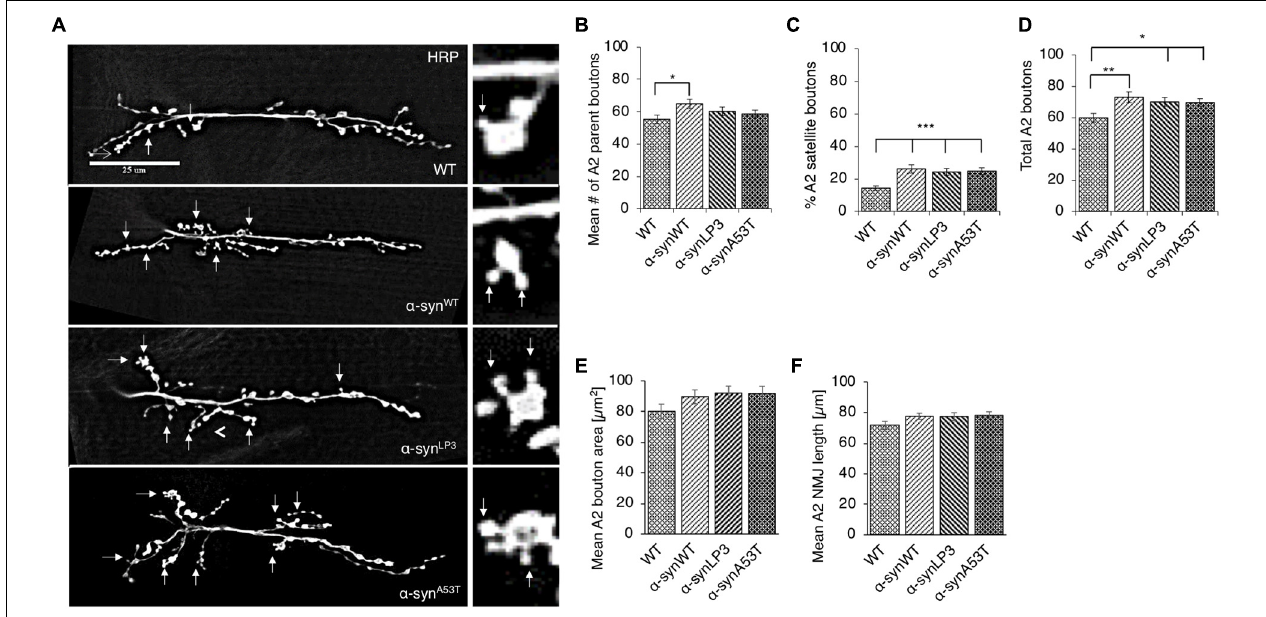
FIGURE 2 | Excess human α -syn causes synaptic morphological defects in Drosophila NMJs. (A) Larval segment A2 of muscle 6/7 from wild-type (WT), α -syn WT , α -syn LP3 , or α -syn A53T stained with the pre-synaptic marker horseradish peroxidase (HRP). Inset of enlarged images shows a single synaptic bouton with satellite boutons budding off (arrows). (B) Quantitative analysis of the mean number of parent bouton in α -syn WT expressing larvae shows a significant increase ( p < 0.05) compared to WT. Expression of α -syn LP3 and α -syn A53T shows no difference in the mean number of parent boutons. (C) Quantitative analysis of the percent (%) of satellite boutons in α -syn WT , α -syn LP3 , and α -syn A53T larvae shows a significant increase compared to WT ( p < 0.001). (D) Quantification of the total number of boutons, which include both parent and satellite boutons, shows a significant increase in α -syn WT ( p < 0.01), α -syn LP3 ( p < 0.05), and α -syn A53T ( p < 0.05) larvae compared to WT larvae. (E) Mean bouton area and (F) NMJs length from α -syn WT , α -syn LP3 , α -syn A53T , or α -syn (cid:49) 71 − 82 show no differences compared to the WT control. Quantitative analysis represents mean ± SEM. ∗ p < 0.05, ∗∗ p < 0.01, ∗∗∗ p < 0.001, n = 15. Bar = 25 µ